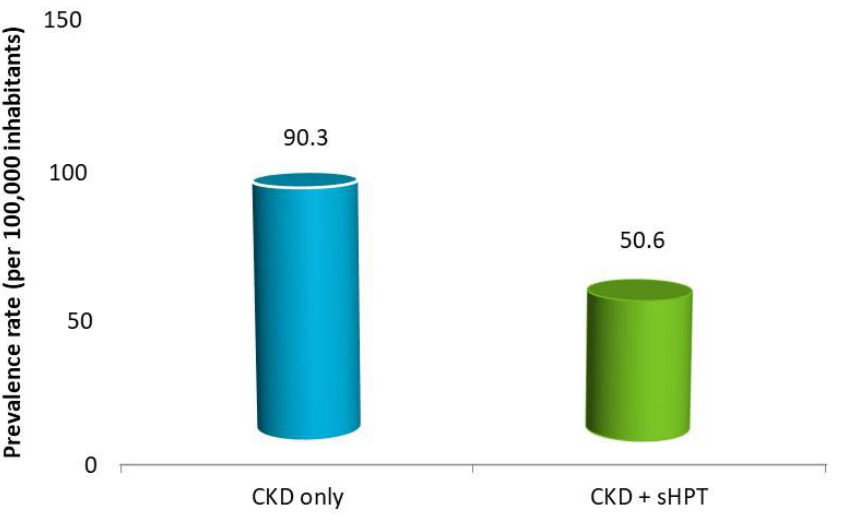
Figure 2. Estimated prevalence in patients with a diagnosis of CKD without (CKD-only) and with sHPT diagnosis (CKD + sHPT).